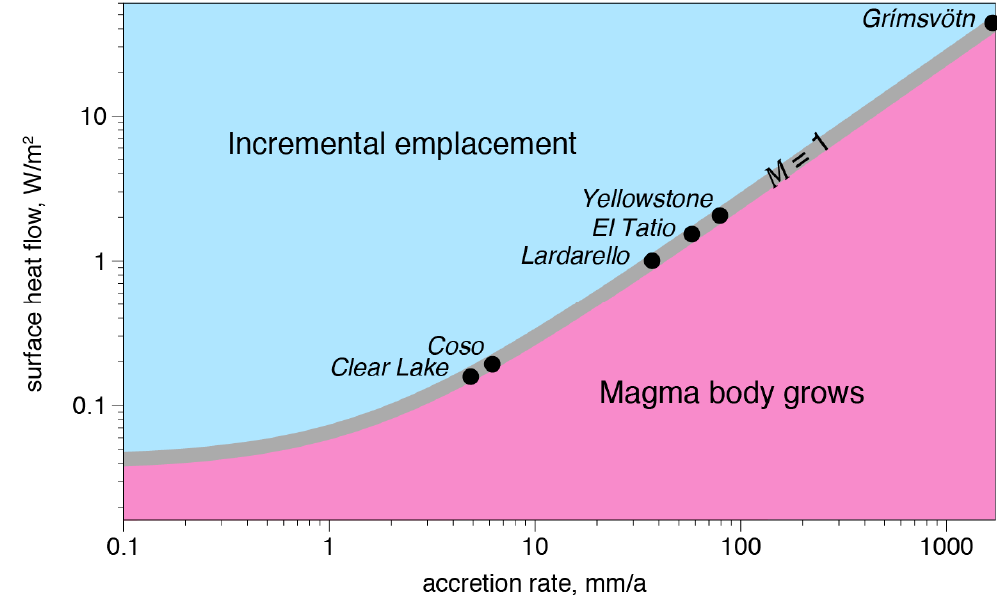
Figure 2. Plot of values of accretion rate and surface heat flow for which the magma accretion number M = 1 (gray boundary). For accretion rates below this, cooling is fast enough that an incrementally emplaced pluton grows; for higher accretion rates, a body of partially molten rock grows. Black dots give estimated surface heat flow at selected geothermal areas, showing the magma accretion rates that would be needed to sustain those heat flows by conduction alone. The fields with high surface heat flow require magma accretion rates far in excess of geodetically observed rates.